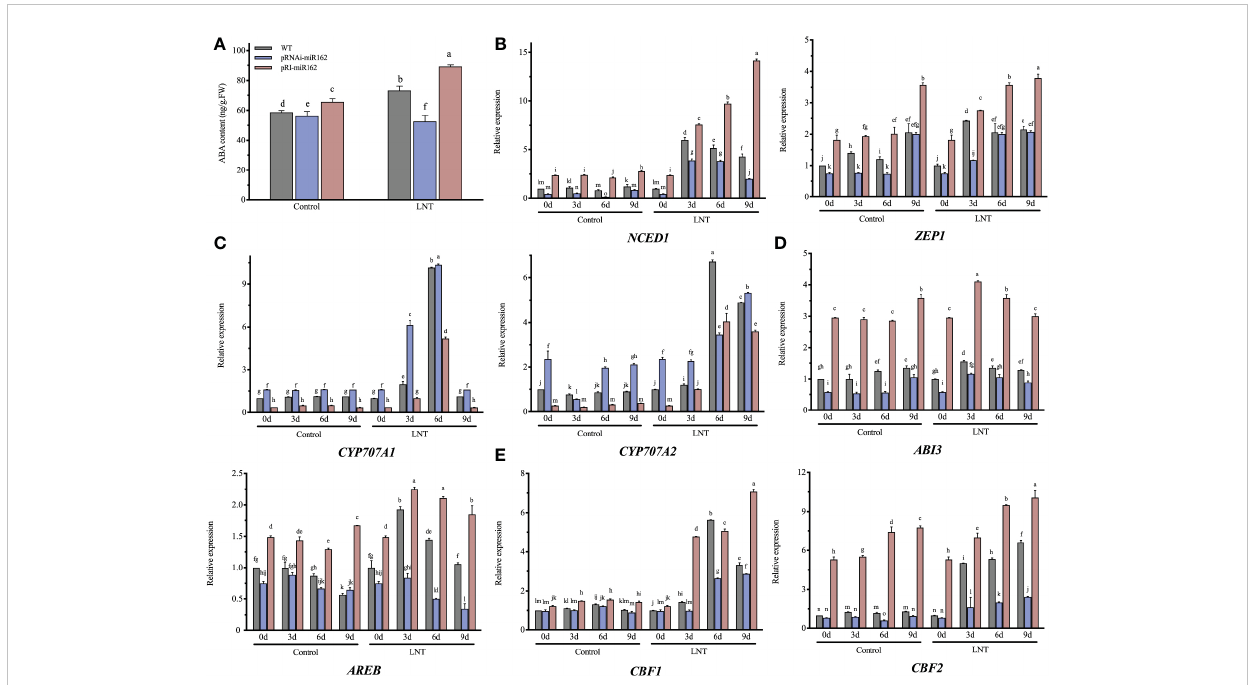
FIGURE 4 Effects of mIR162 on the ABA signaling pathway in response to LNT stress. (A) ABA content of miR162 transgenic lines under LNT stress. (B) Expression of ABA biosynthesis genes in miR162 transgenic lines during LNT stress. (C) Expression of ABA catabolism genes in mIR162 transgenic lines during LNT stress. (D) Expression of ABA responsive genes in miR162 transgenic lines during LNT stress. (E) Expression of ABA-related cold-induced genes in miR162 transgenic lines during LNT stress. (D) Days of LNT treatment (0, 3, 6, and 9 days). Control: 25°C/15°C, LNT stress: 25°C/6°C (day/night temperature). Data are mean standard error of four independent experiments (n = 4). Lowercase letters indicate signi fi cant ferences at P < 0.05 according to Tukey's